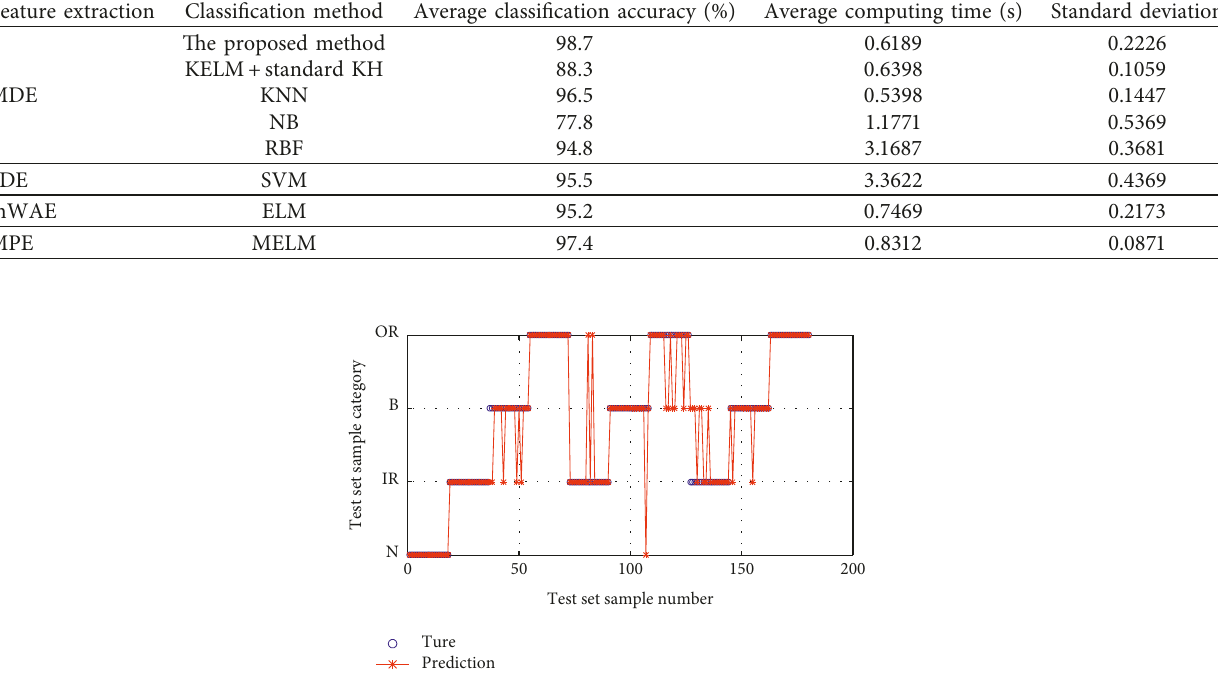
Figure 14: Bearing diagnosis of the KELM optimized by the standard krill herd algorithm: results of NKH-KELM with classification accuracy �